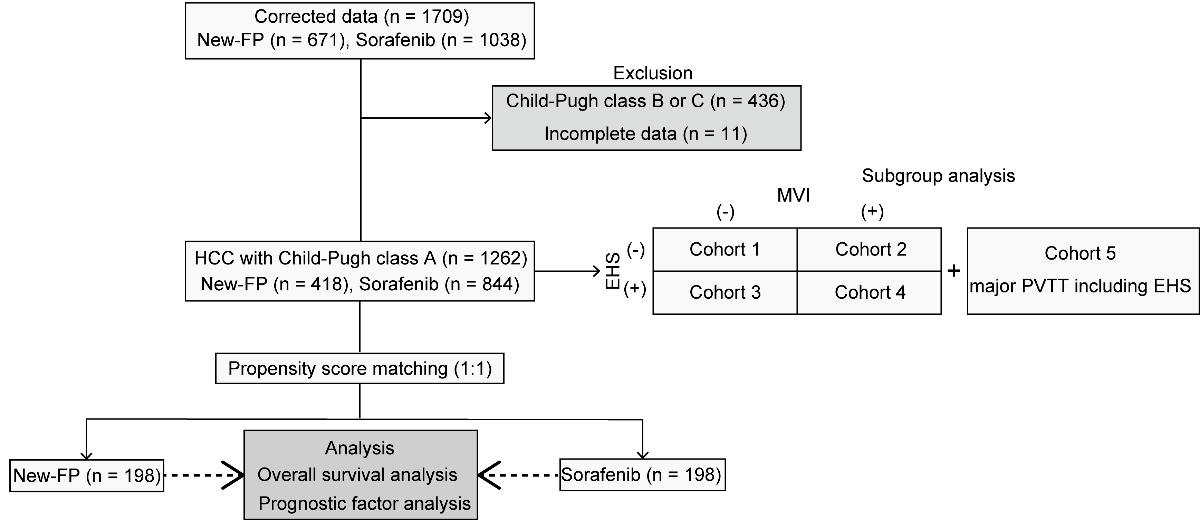
Figure 1. Flowchart illustrating the study inclusion and exclusion process. EHS, extrahepatic spread; MVI, macrovascular invasion; New-FP, fine-powder cisplatin and 5-fluorouracil; PVTT, portal vein tumor thrombus.